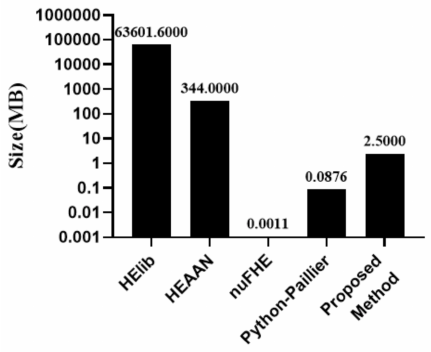
Figure 13. Size comparison of encrypted database for 10,000 records.